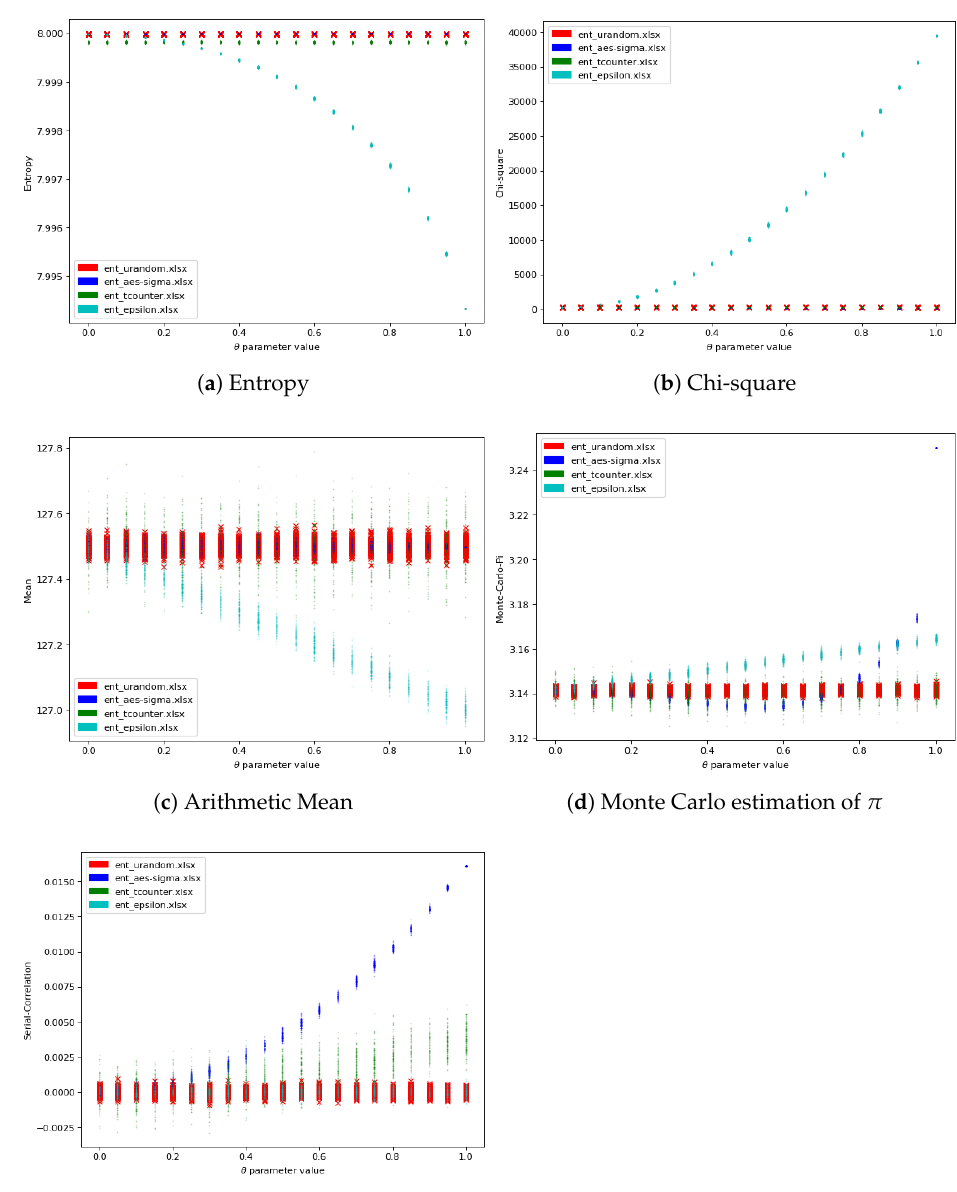
Figure 1. Result of the statistics for each generator and the values of θ